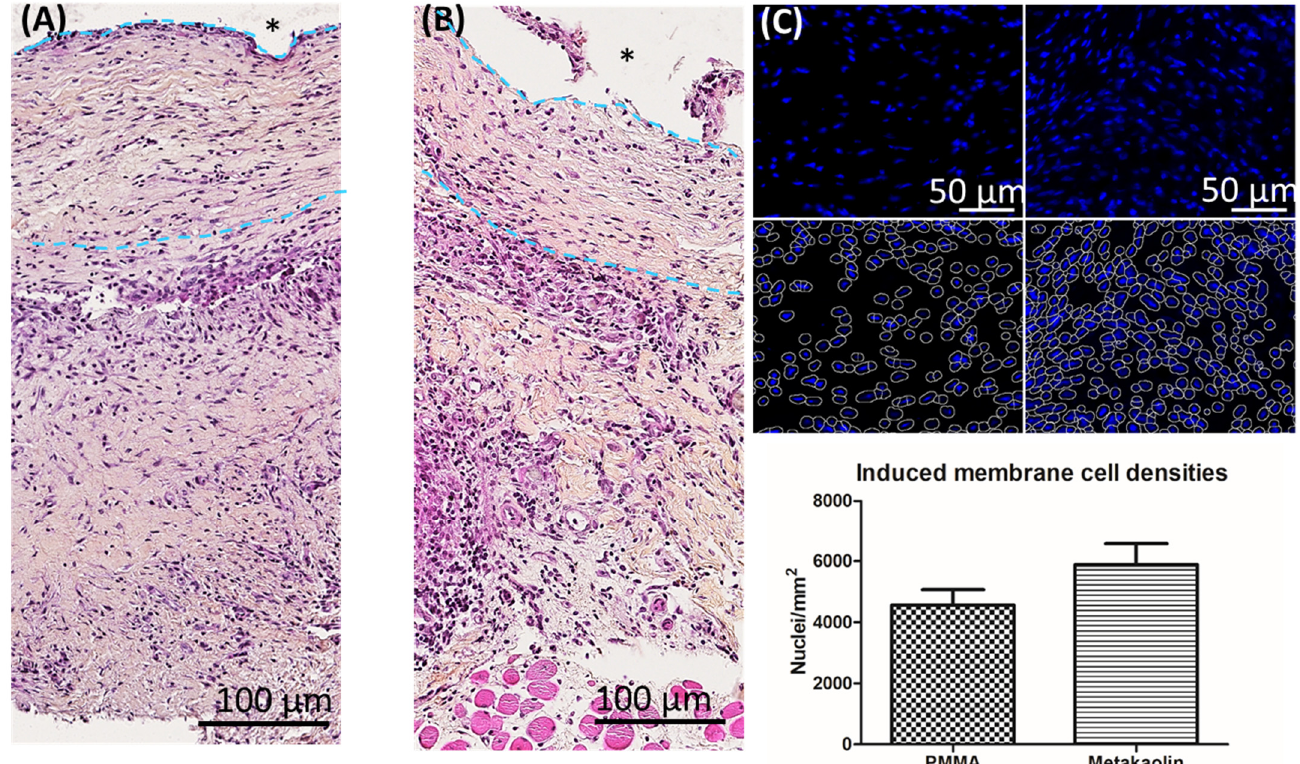
Figure 2. Representative hematoxylin-eosin-saffron-stained sections of ( A ) PMMA-IMs and ( B ) metakaolin-IMs showing their histological organization. * Indicates the site of the spacer before its removal. The right panel ( C ) illustrates the semi-automatic counting process of DAPI-stained nuclei and the comparison of cell density (the mean number of nuclei per mm 2 ± SEM) in PMMA-IMs and metakaolin-IMs.